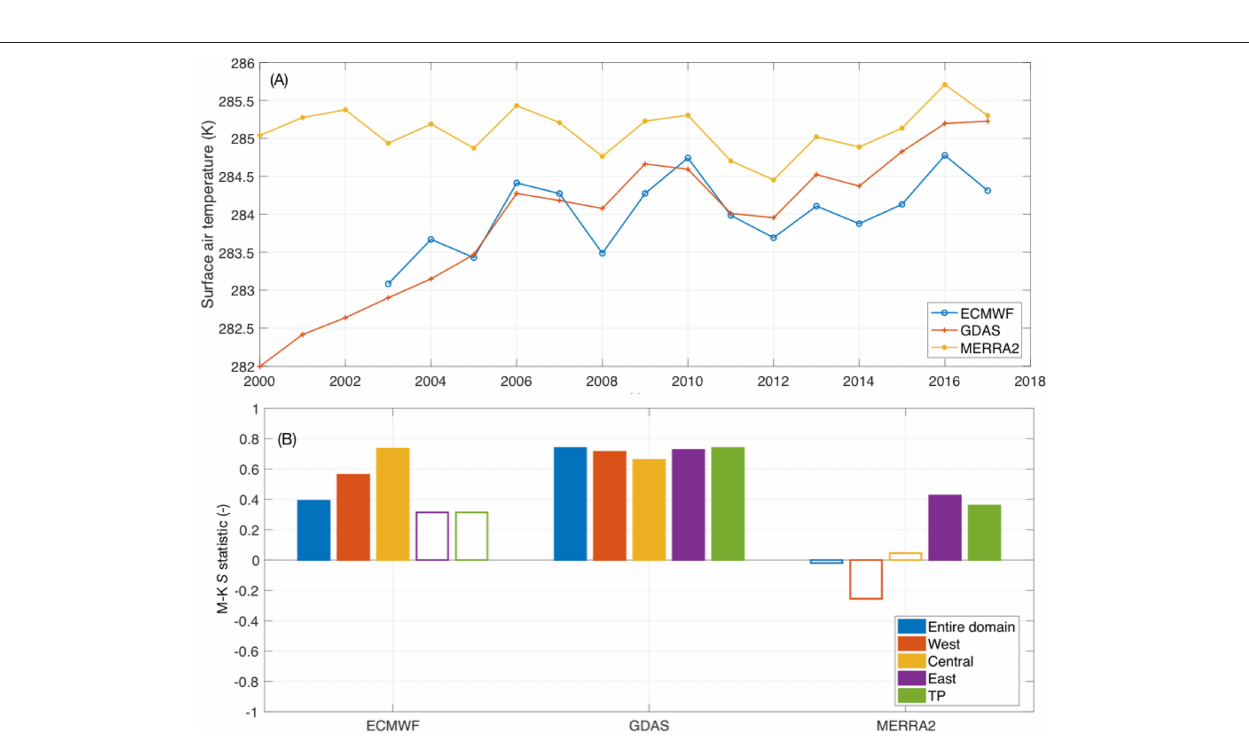
FIGURE 9 | Time series of domain-averaged mean annual near surface air temperature (A) , and estimates of the Mann Kendall S -statistic (B) for the entire HMA and four sub-regions ( Figure 1 ). The statistically significant trends are shown with filled boxes.